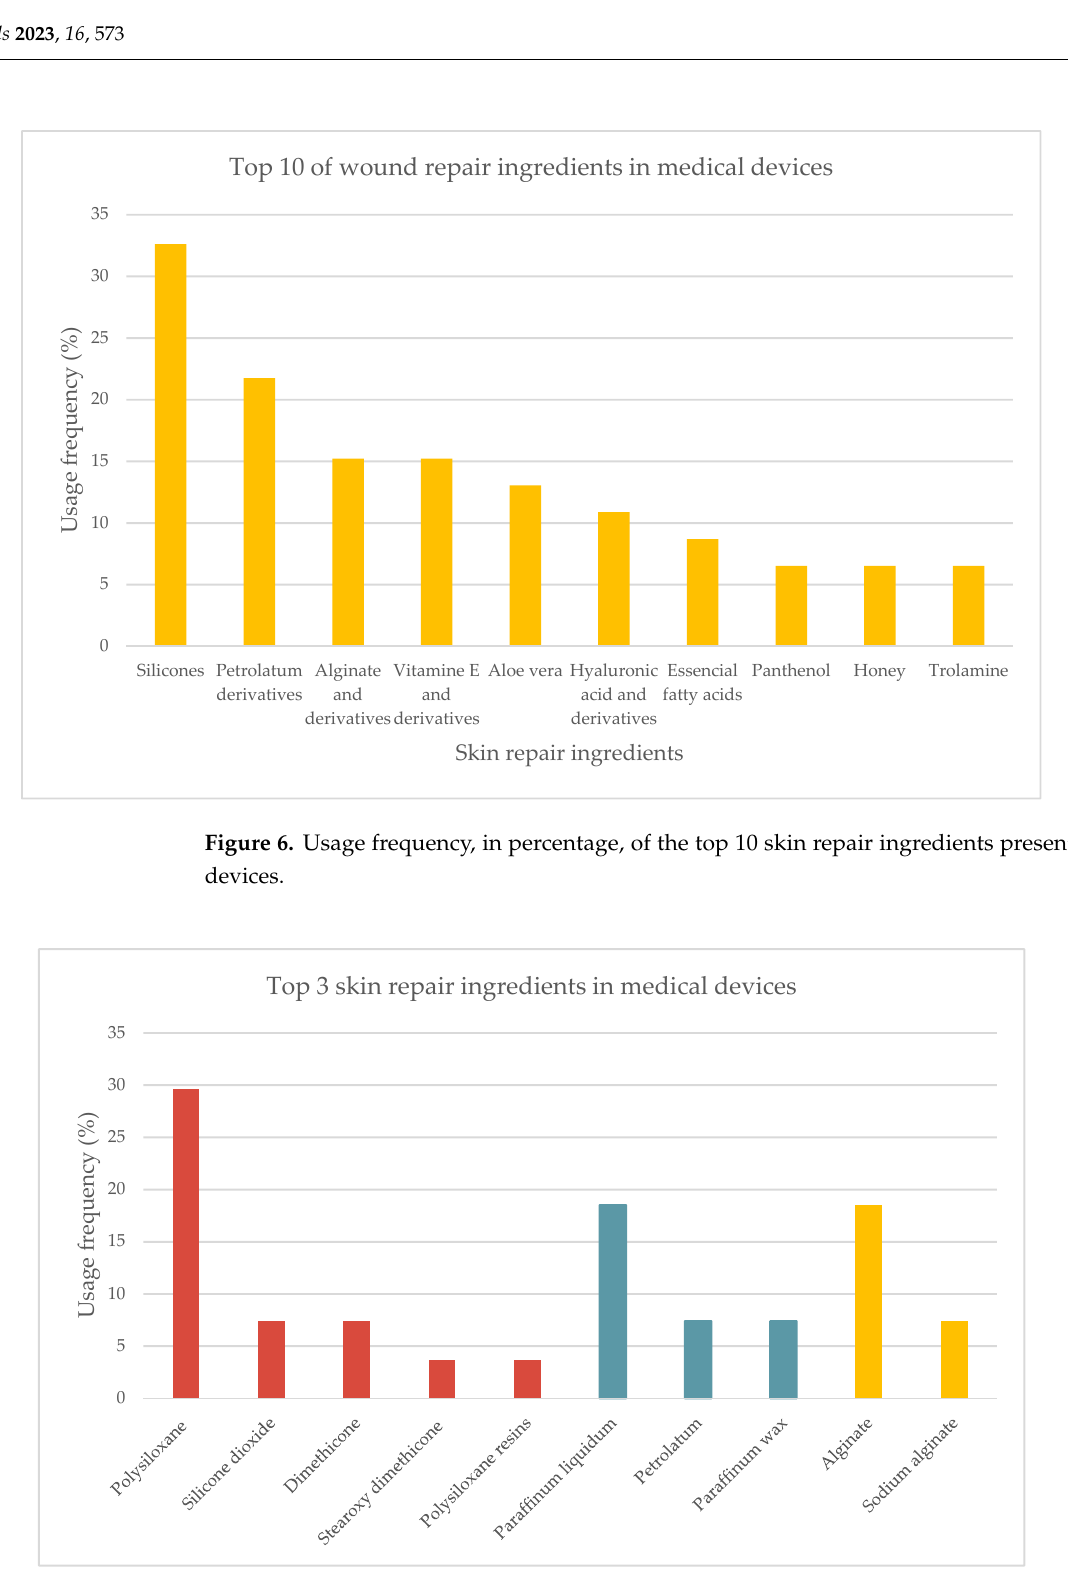
Figure 7. Usage frequency of the top 3 most used skin repair ingredients and actives in medical de- vices extended: silicones and derivatives (red), petrolatum derivatives (blue), alginate and derivative